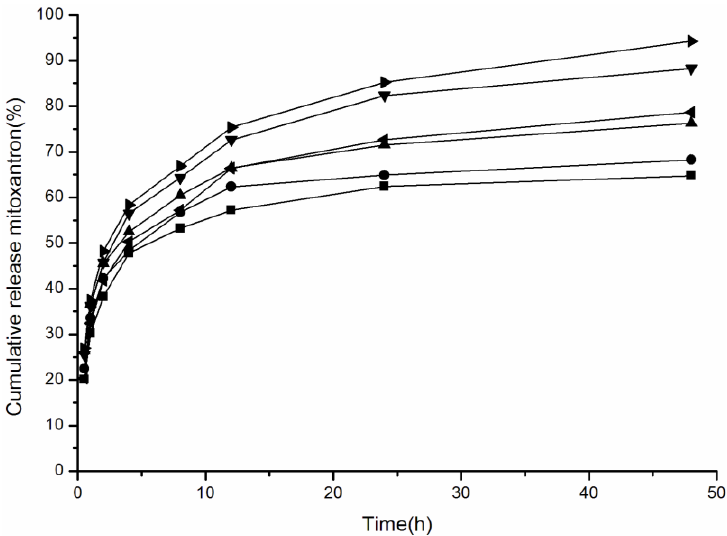
Figure 6. MTO release from NPs in phosphate buffered saline buffer (pH 6.8) at 37 °C in vitro and acetate buffer (pH 4.0) (pH 6.8: ■ CHP, ● CHCP, ▲ CHAP; pH 4.0: ◄ CHCP, ▼ CHP, ► CHAP).